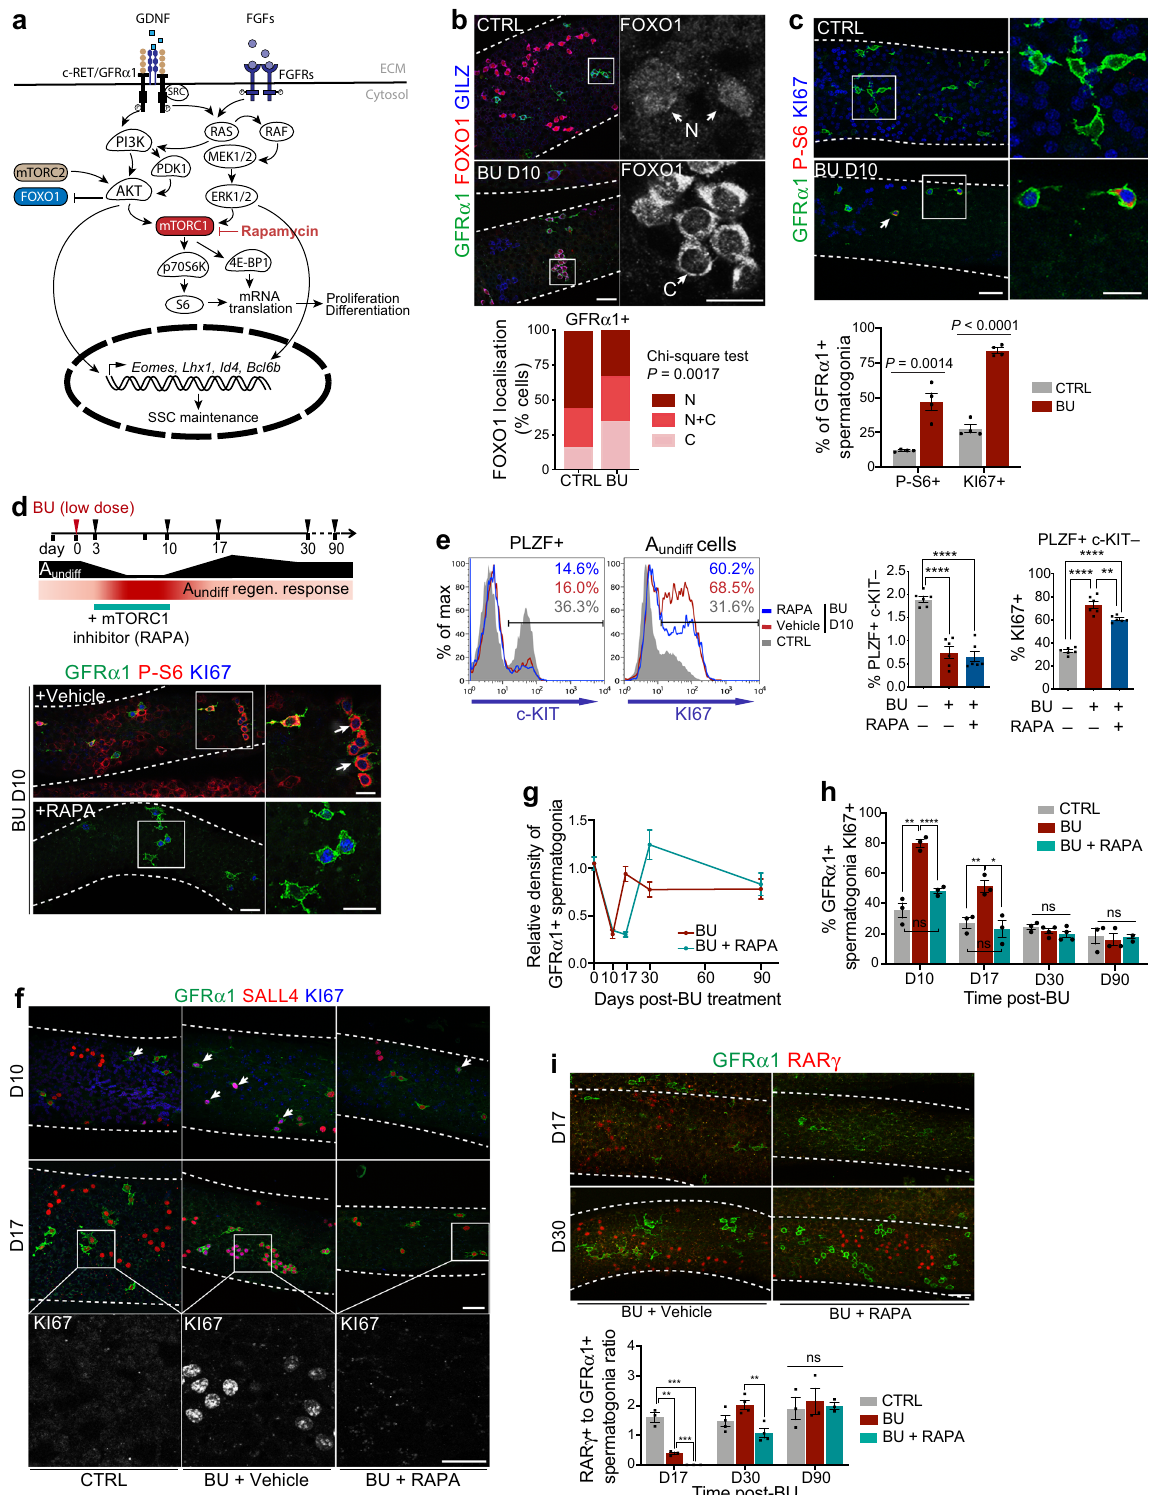
surviving SALL4 + spermatogonia at D10 post-BU was substan- tially reduced by AD80 treatment (Supplementary Fig. 7c). However, persisting A s and A pr could be identi fi ed by IF for E-Cadherin (Fig. 5a, b). Whereas E-Cadherin + A s /A pr of D10 vehicle-treated controls exhibited mostly cytosolic FOXO1 as anticipated, AD80 treatment caused re-localisation of FOXO1 to the nucleus, indicating that AD80 inhibited AKT signalling in